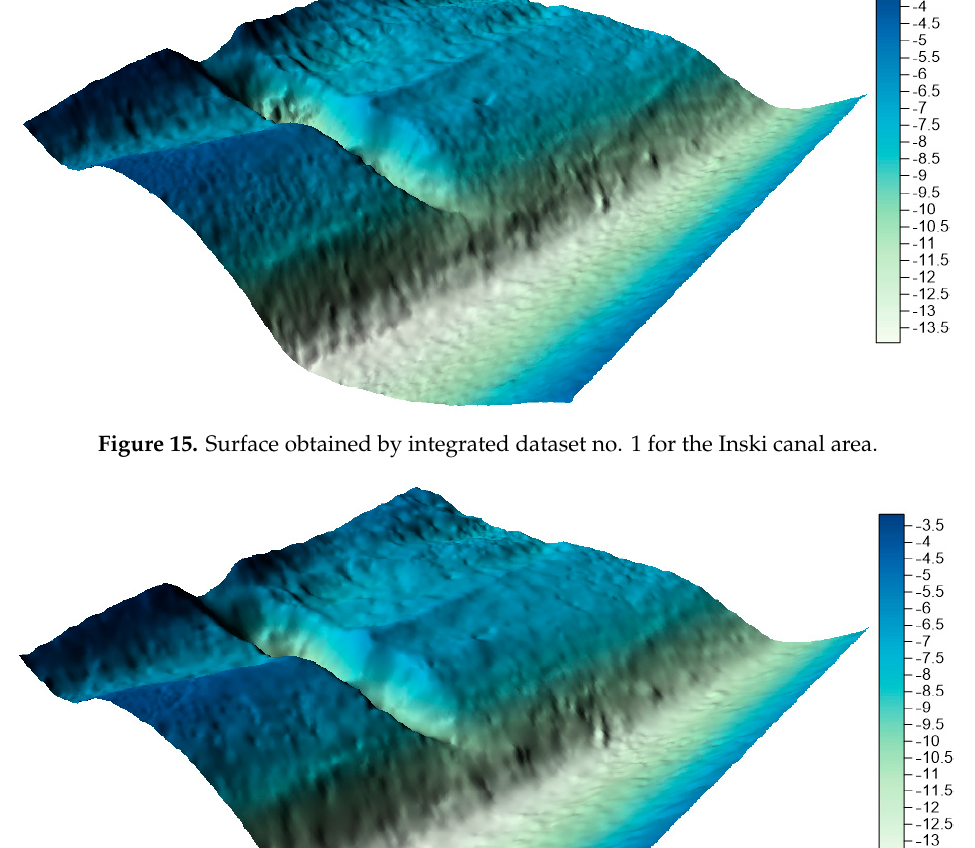
Figure 17. Surface obtained by integrated dataset no. 3 for the Inski canal area.